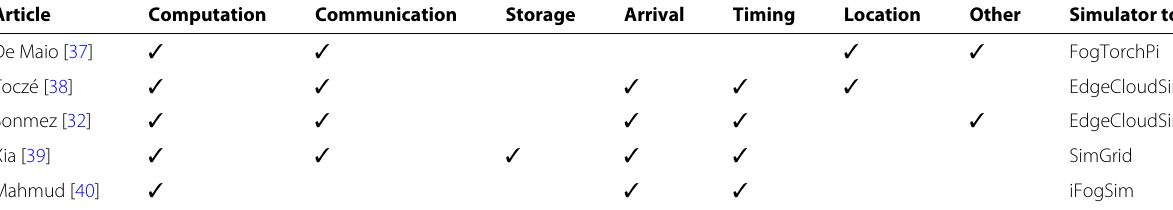
Table 2 What load indicators are considered in selected works using simulation